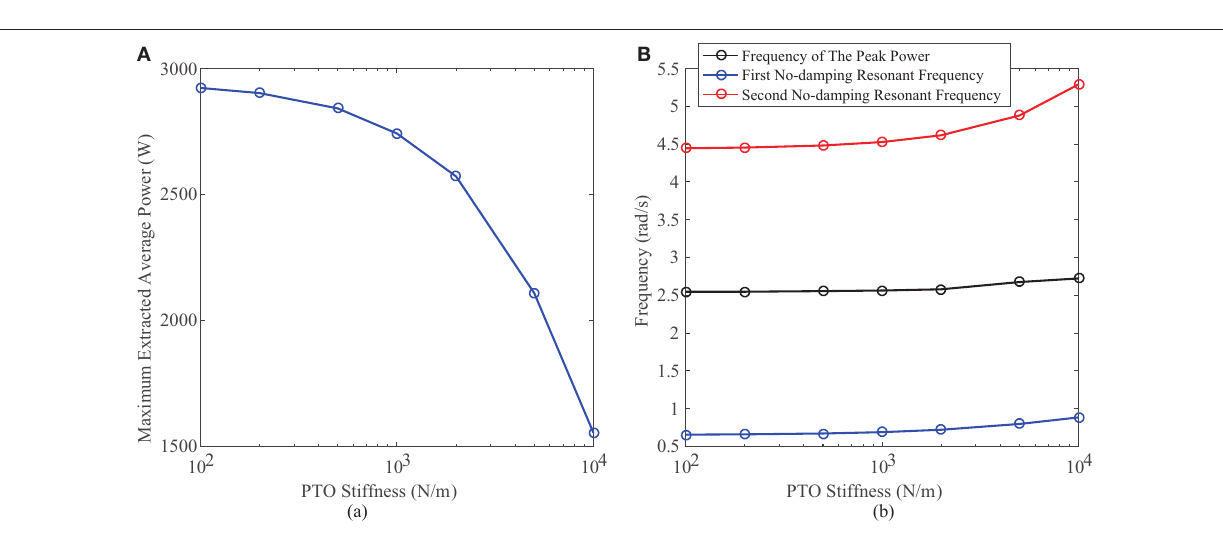
FIGURE 4 | (A) Maximum extracted average power vs. PTO stiffness. (B) Resonant frequencies vs. PTO